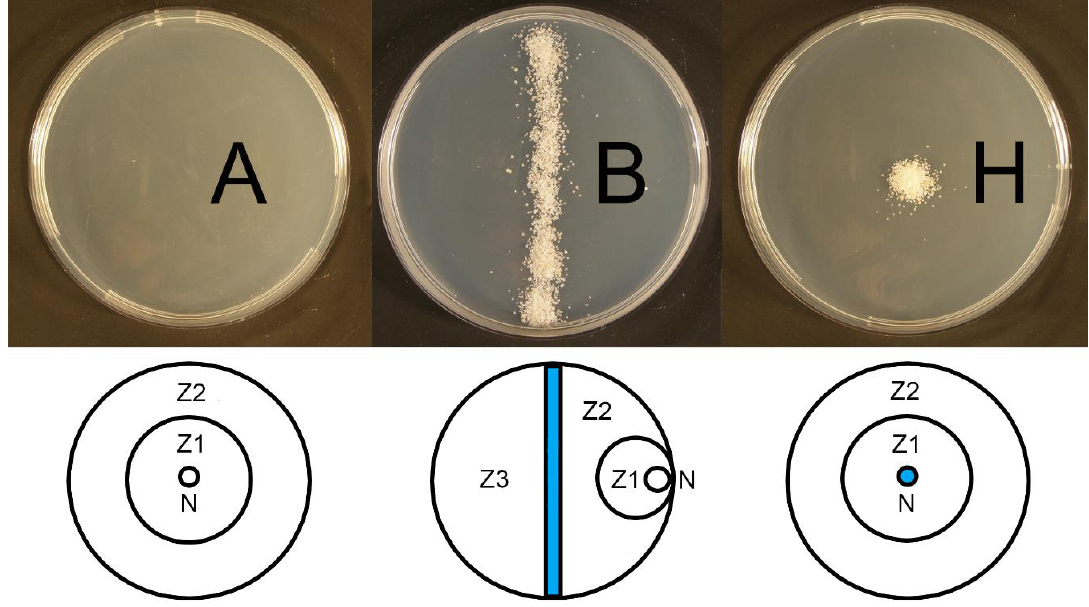
Figure 1. Design of the potato dextrose agar (PDA) plate experiments and zones for nematodes’ dispersal evaluation. Clean agar ( A ), silver sand barrier ( B ) and silver sand heap ( H ), Zones 1–3 (Z1–Z3), nematode or nematodes / fungus application side (N), sand marked with blue color.